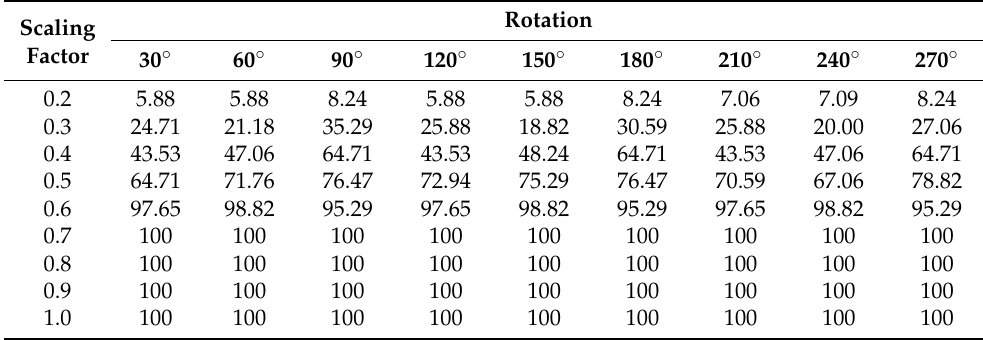
Table 2. The correct recognition rates for a combination of rotation angles and scaling factors for the log-polar-FFT2 method for the printed Chinese character dataset. Scaling